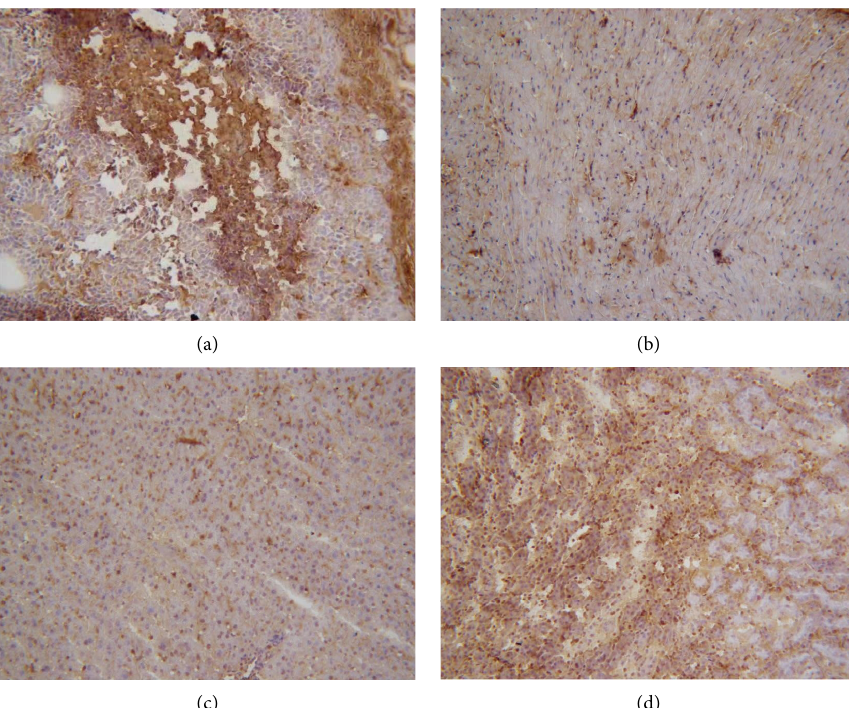
Figure 8: Immunohistochemical detection of tumor and its organs (heart, liver, kidney) in nude mice. (a) Nude mice tumors in the experimental group (300 μ g/graphene carrier complex, × 200); (b) heart of the nude mice (300 μ g/graphene carrier complex, × 200); (c) liver of the nude mice (300 μ g/graphene carrier complex, × 200), (d) kidney of the nude mice (300 μ g/graphene carrier complex, × Table 2 is the blood routine test results of mice in each group after administration.